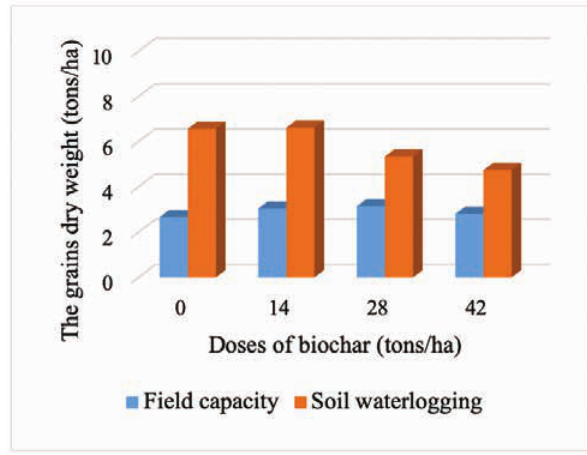
Figure 1: The Interaction between Soil Water Content and Biochar Application on the Shoots Dry Weight